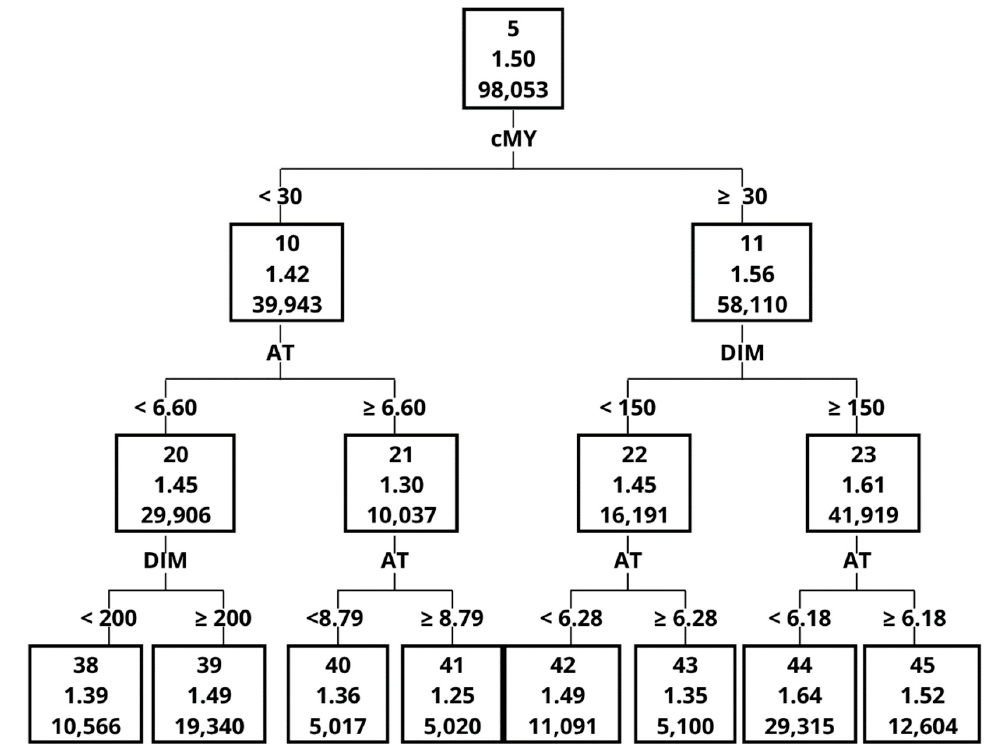
Figure 4. The graphical model of the decision tree—part 3.